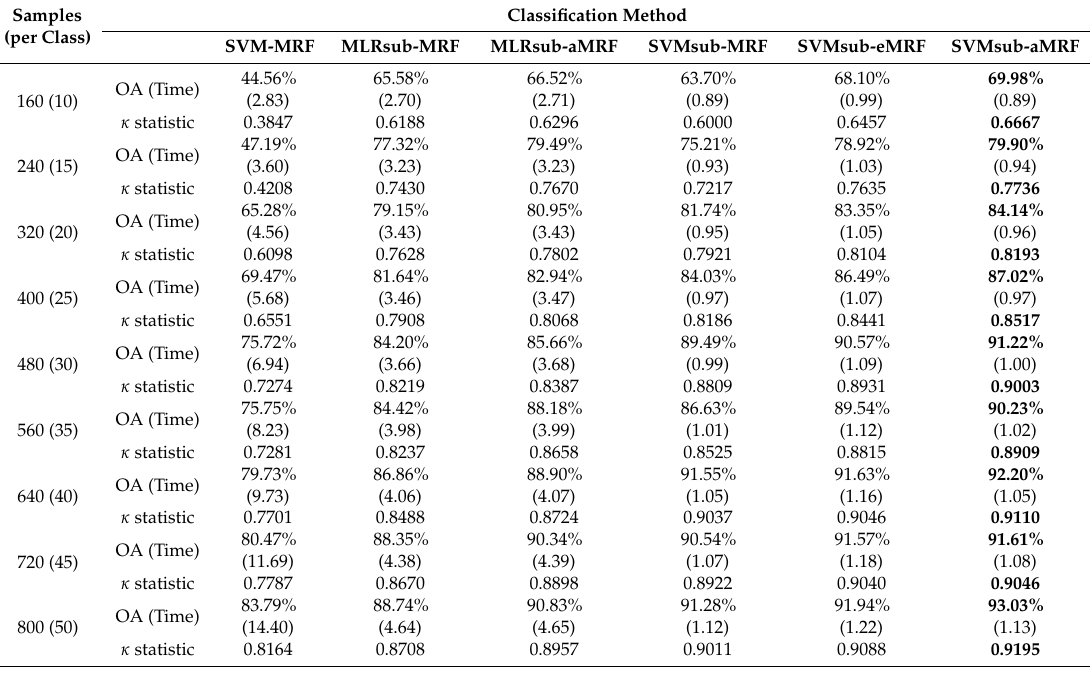
Table 3. Overall classification accuracies (in percent) and κ statistic values obtained by the various tested methods for the AVIRIS Indian Pines scene using different numbers of training samples. The computational costs (in parentheses) are also presented. Both the total number of samples used and the (approximate) number of training samples per class (in parentheses) are shown.